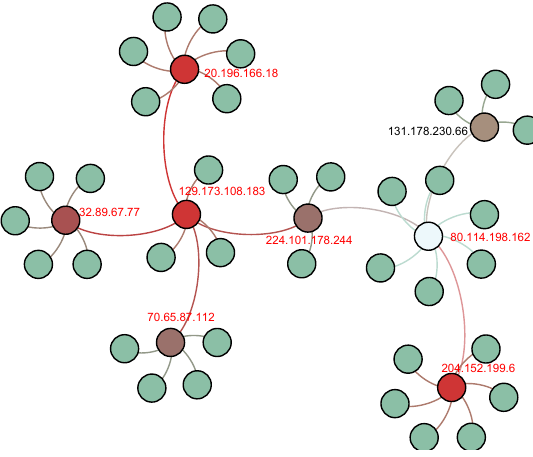
Figure 10. Complete cascading motif captured from the polyworm test.